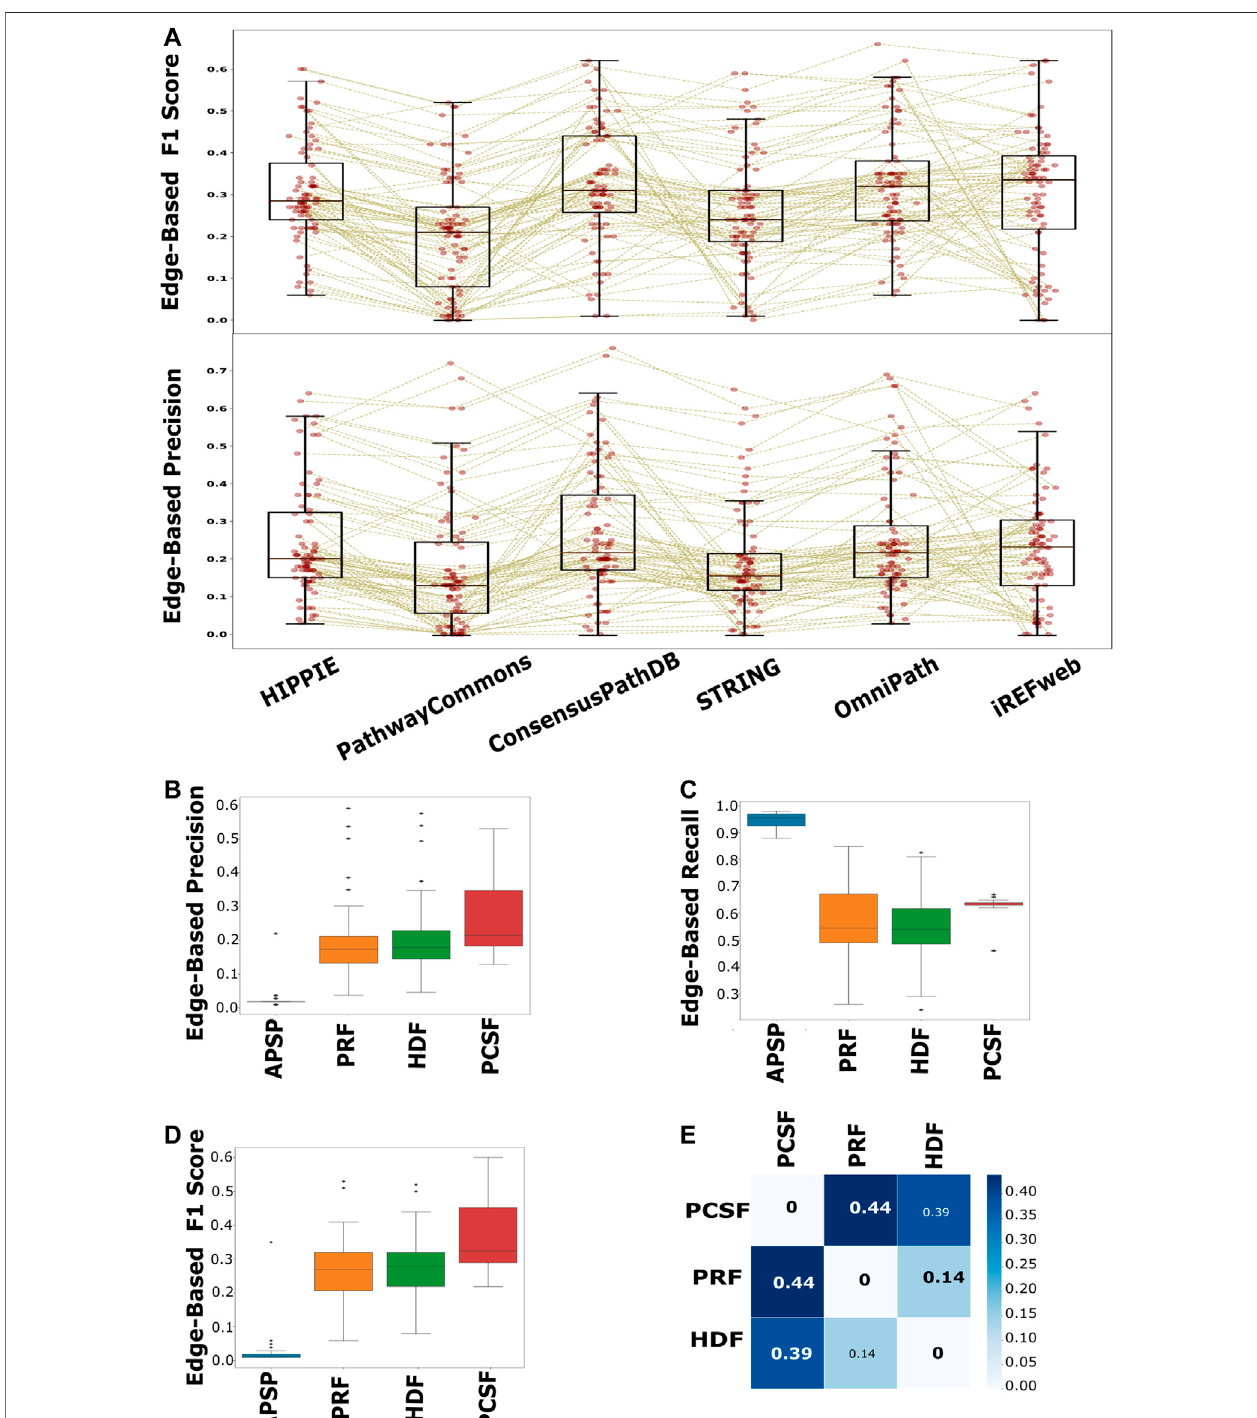
FIGURE 6 | Performance evaluation of each interactome and method in pathway reconstruction. (A) Boxplot of edge-based precision and F1 scores, for each interactome,showsthatPathwayCommonsandSTRINGaresigni fi cantlylowerthanHIPPIE,ConsensusPathDB,OmniPath,andiRefWeb,whilethereisnotanydistinct difference among HIPPIE, ConsensusPathDB, OmniPath, and iRefWeb. The performance values for each reconstructed network is represented with red points in the boxplots. Brown lines connect the performance scores of the same pathway across the interactomes. (B) Edge-based precision, (C) edge-based recall, and (D) edge-based F1 scores are separately demonstrated for reconstruction algorithms. (E) HDF, PRF, and PCSF were compared in terms of the reconstructed pathways. The heatmap shows that the reconstructed pathways by PCSF are different, having %44 and %39 different edges, respectively, than the ones reconstructed by PRF and